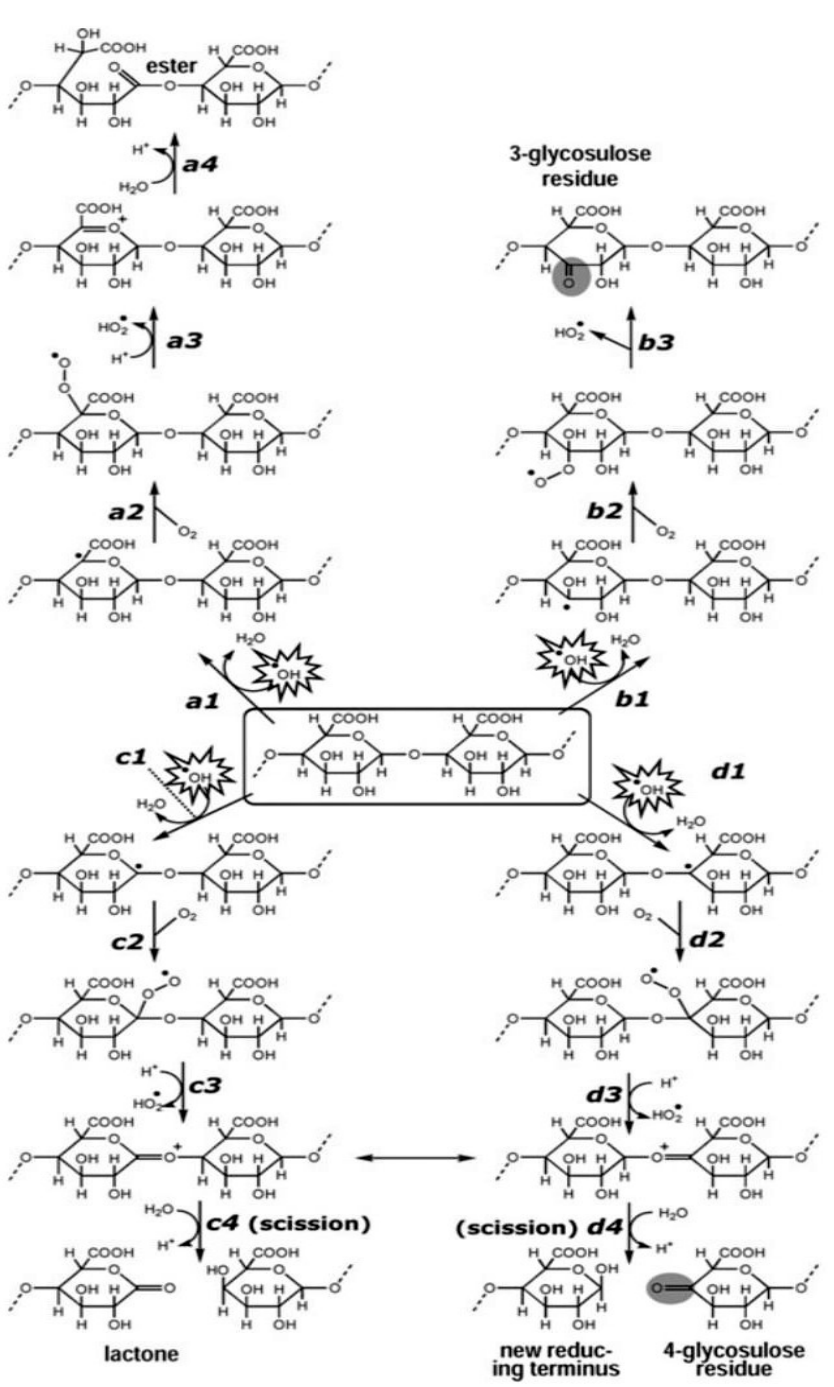
Figure 7. Proposed reaction mechanism of OH • on a polysaccharide chain. The diagram shows some of the proposed reaction mechanism of polysaccharide (homogalacturonan) exerting its antioxidant capacity on OH•, where the short lines (- - -) depicts the polysaccharide chain continuation. This figure presents the predicted reactions occurring after • OH abstracts a hydrogen atom from C-1 (reactions c1–c4), C-3 (reactions b1–b3), C-4 (reactions d1–d4) or C-5 (reactions a1–a4). Abstraction of hydrogen from C-2 (not shown) is expected to give products directly comparable with those shown for C-3. (Source: Vreeburg et al. [140]).